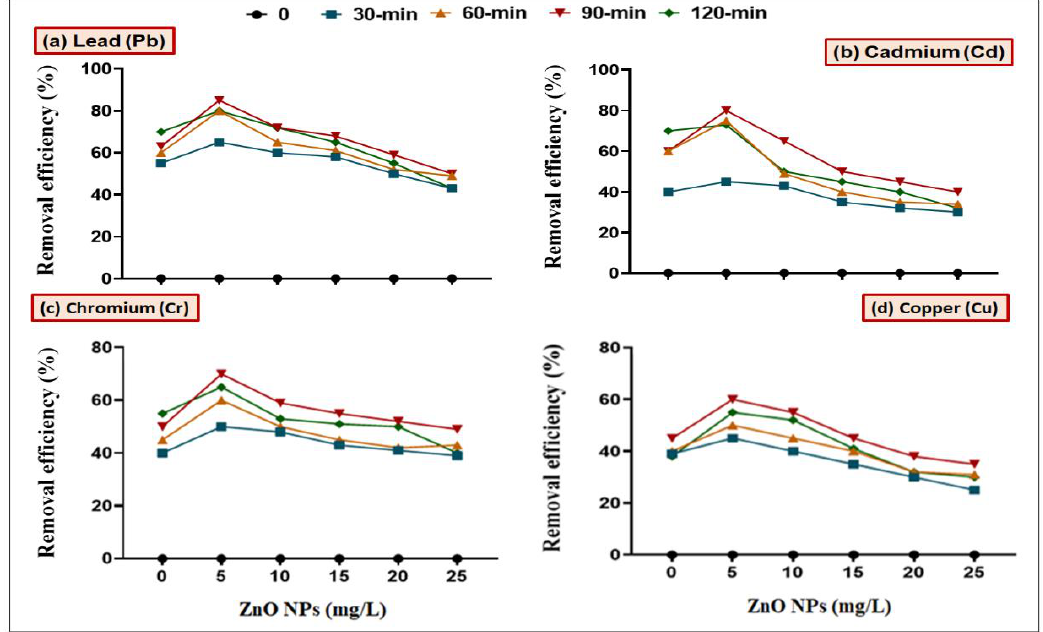
Figure 3. Synergistic effect of B. cereus and ZnO NPs (5, 10, 15, 20 and 25 mg/L) on the removal efficiency of ( a ) Lead (Pb), ( b ) Cadmium (Cd), ( c ) Chromium (Cr) and ( d ) Copper from the media amended with heavy metal at different time intervals (0, 30, 60, 90 and 120 min).